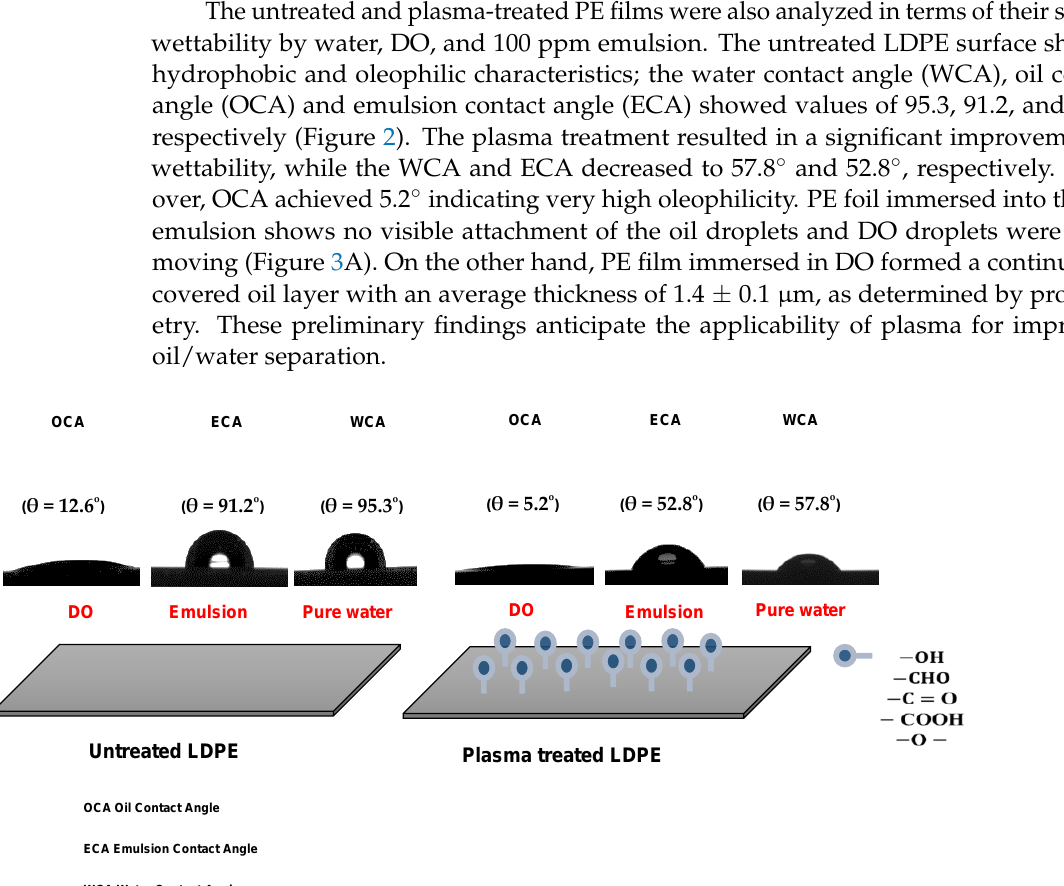
Figure 1. Dependence of ( a ) contact angle and ( b ) surface free energy (SFE) of selected liquids on plasma treated low- density polyethylene (LDPE) foil on treatment time .